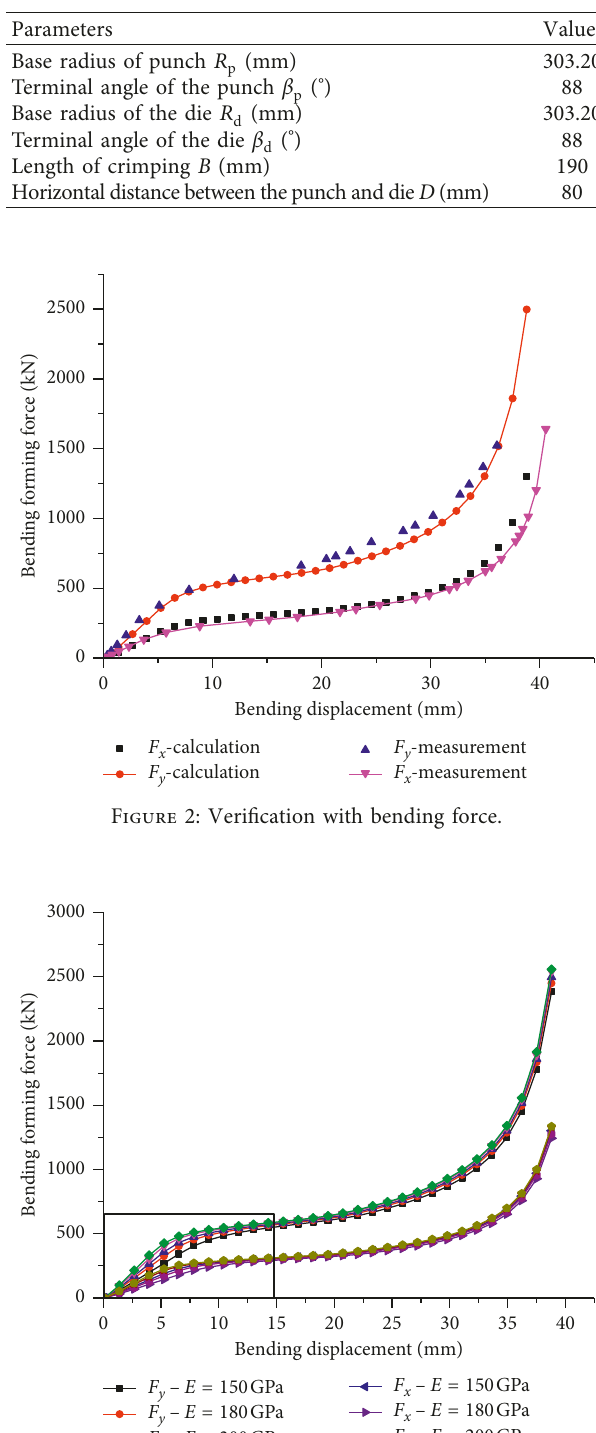
Table 1: Parameters of the crimping mold.